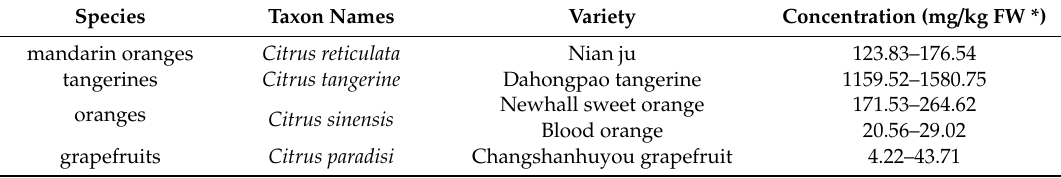
Table 1. Daily foods containing nobiletin and the relative concentrations.